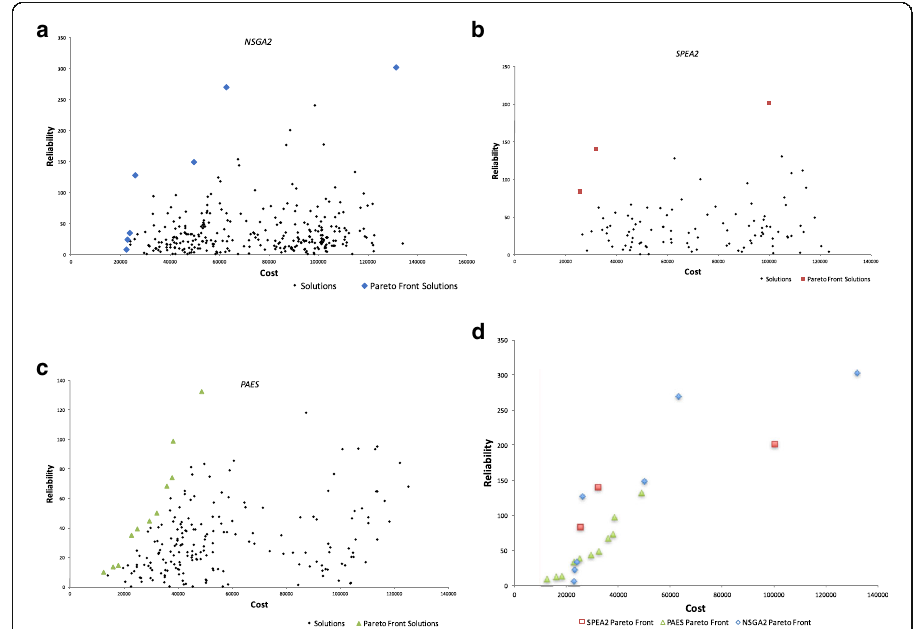
Fig. 6 Performance of ( a ) NSGA2, ( b ) SPEA2, ( c ) PAES, and ( d ) Comparisons of Pareto fronts generated